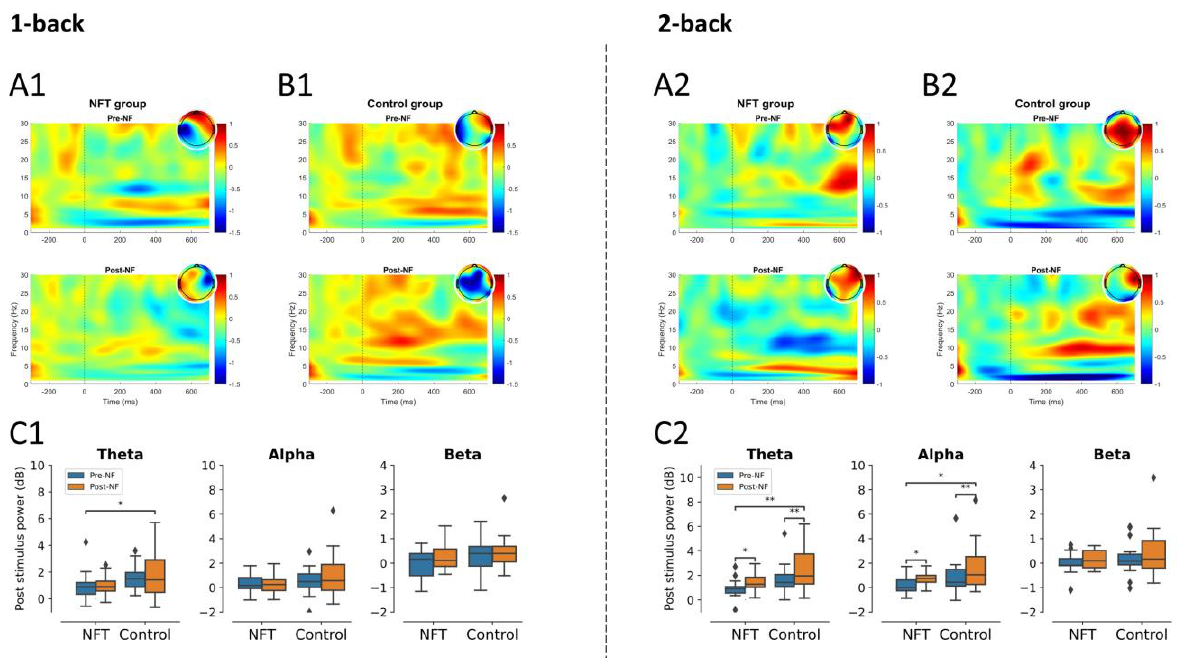
Figure 6. Post-stimulus power fronto-central lobe (* p < 0.05, ** p < 0.005): 1-back post-stimulus power in ( A1 ) NFT group and ( B1 ) control group; 2-back post-stimulus power in ( A2 ) NFT group and ( B2 ) control group. Post-stimulus power in different EEG bands within each group in ( C1 ) 1-back and ( C2 ) 2-back conditions. The colour bar of the TF plots represents the value of EEG power in dB scale. The diamond shape in the box plots represents the outliers in the data.